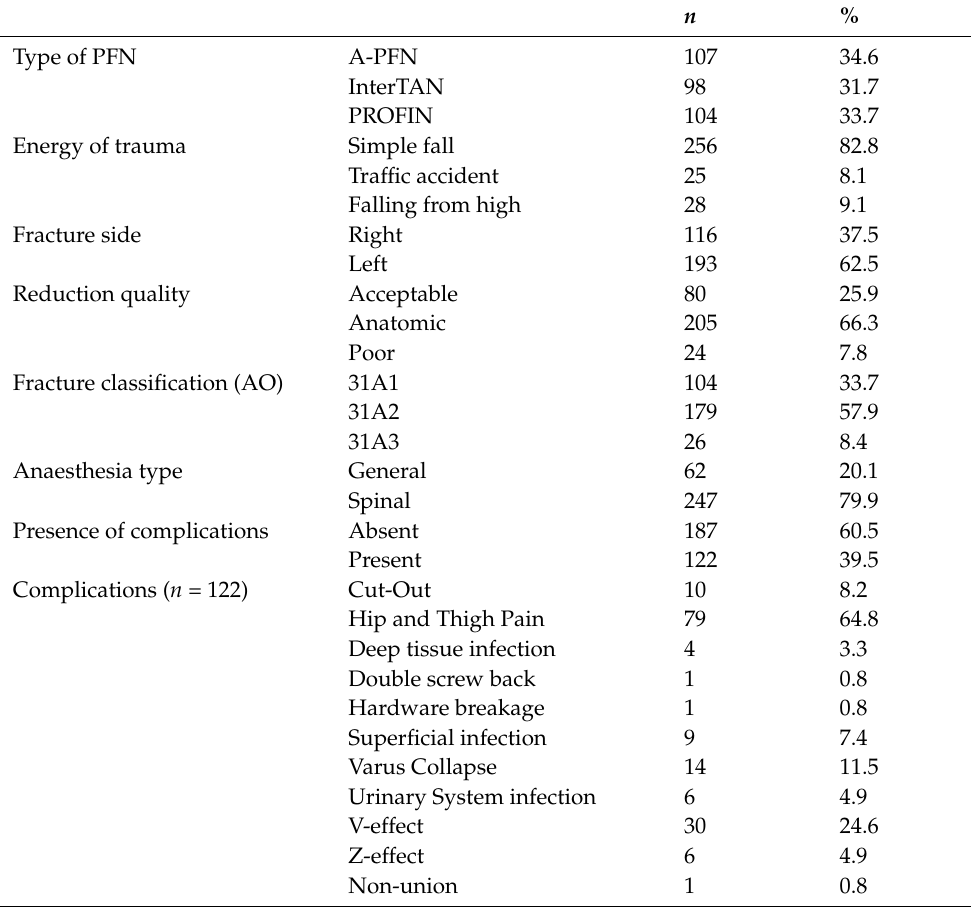
Table 3. The descriptive features of the